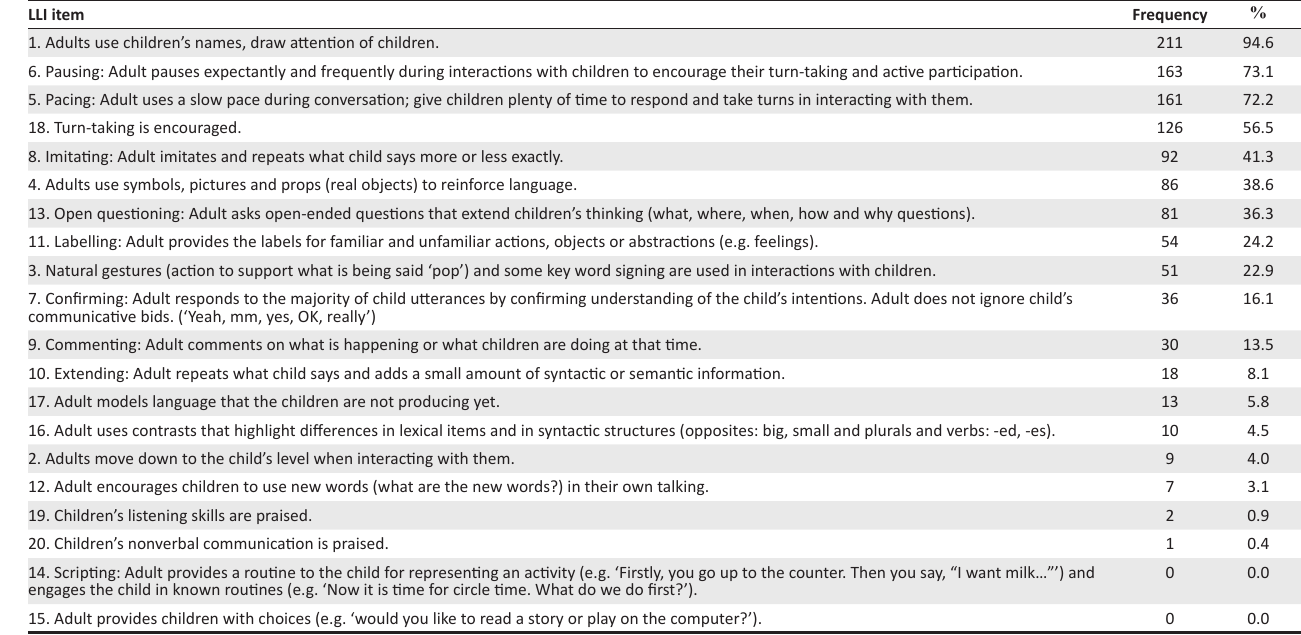
TABLE 2: Number and proportion of observations that indicated a score ≥ 4 in each item of the language-learning interaction area ( N = 223). LLI item Frequency